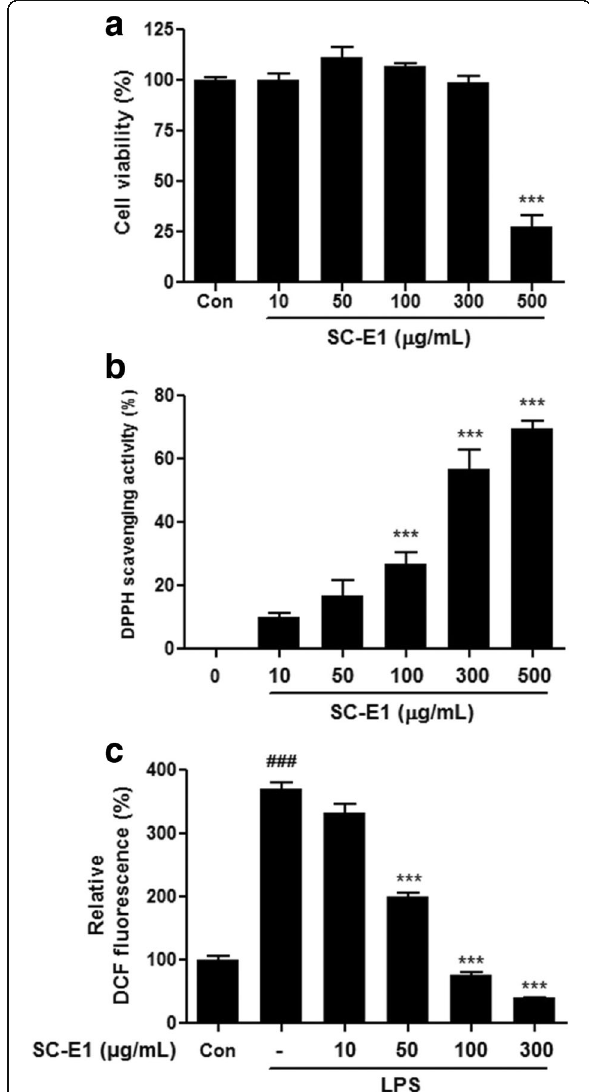
Fig. 2 Effects of SC-E1 on the cell viability and oxidative stress. a Cell viability of SC-E1 treated RAW 264.7 macrophages. RAW 264.7 macrophages were treated with 10 – 500 μ g/ml of SC-E1 for 24 h. The cell viability was measured by an MTT assay. b Anti-oxidant activity of SC-E1 was evaluated by a DPPH scavenging assay. Data are represented as the percent of DPPH radical inhibition. c Effect of SC-E1 on ROS generation. Intracellular H 2 O 2 production was monitored by measuring the DCF fluorescence using a fluorescence microplate